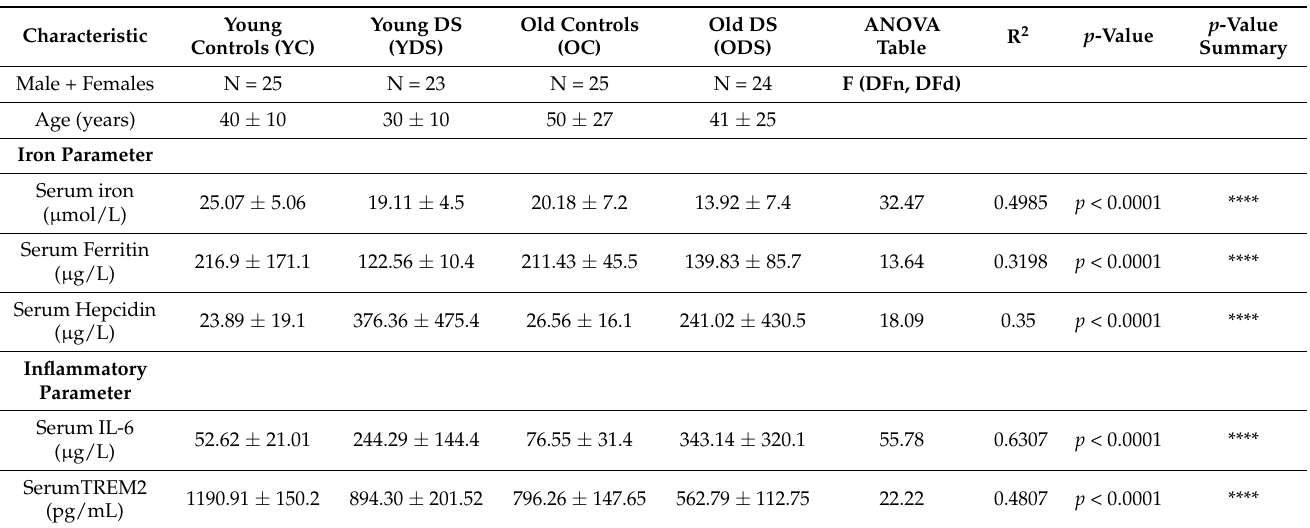
Table 2. Characteristics of DS and age-matched control study population used to measure serum iron, ferritin, hepcidine, IL-6 and